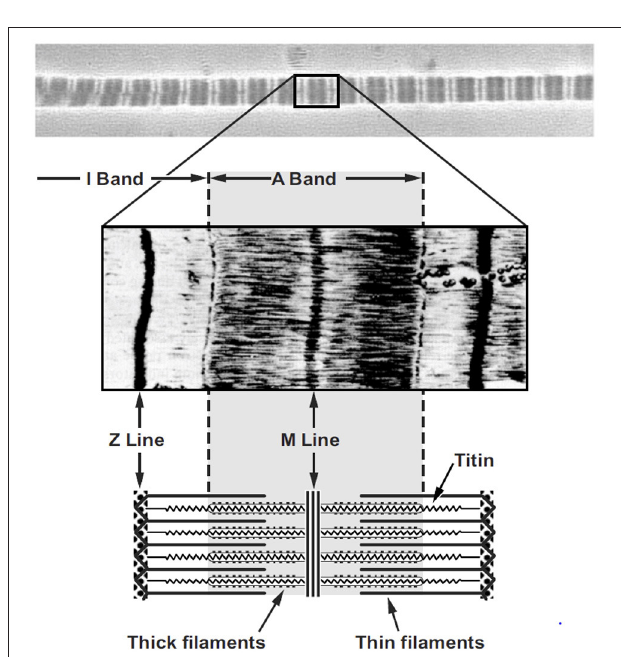
FIGURE 9 | Schematic figure of different structural arrangements of fibers relative to the long axis of the muscle. See text for further explanation and